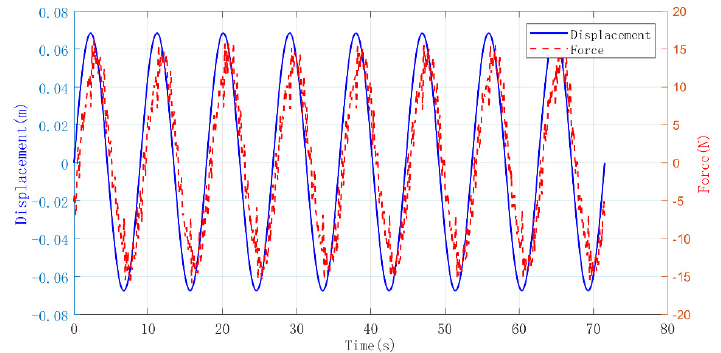
Figure 9. The measured hydrodynamic force and the heave displacement of the heave plate.